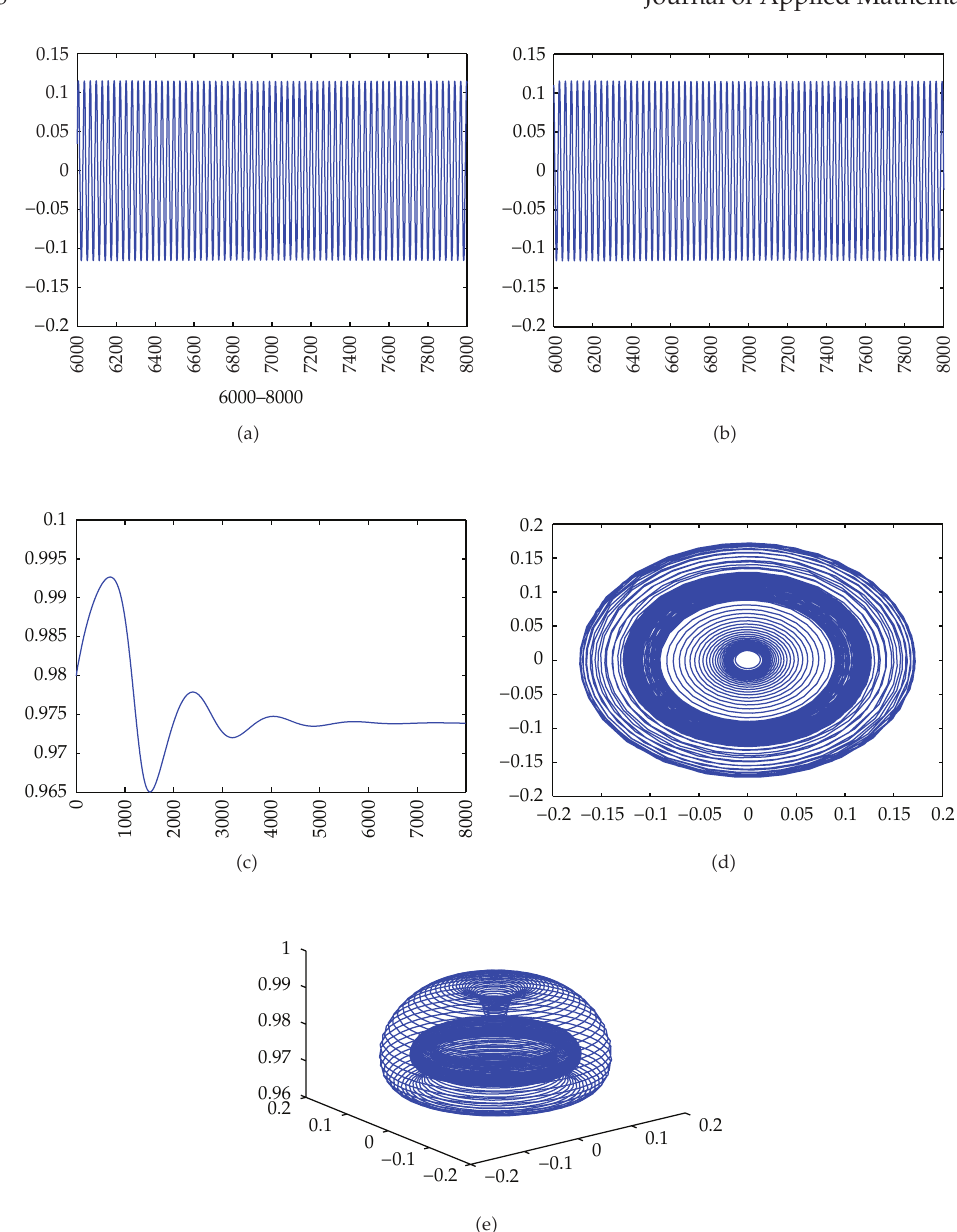
. (cid:7) 0 . 7507, and the 0 and the initial value is taken 0